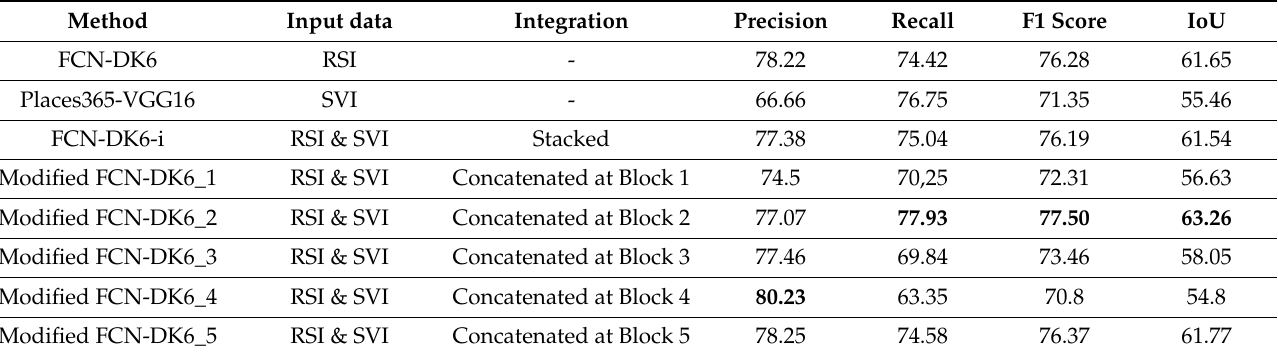
Table 3. Accuracy metrics for the eight different experimental set-ups. Results in bold indicate the highest